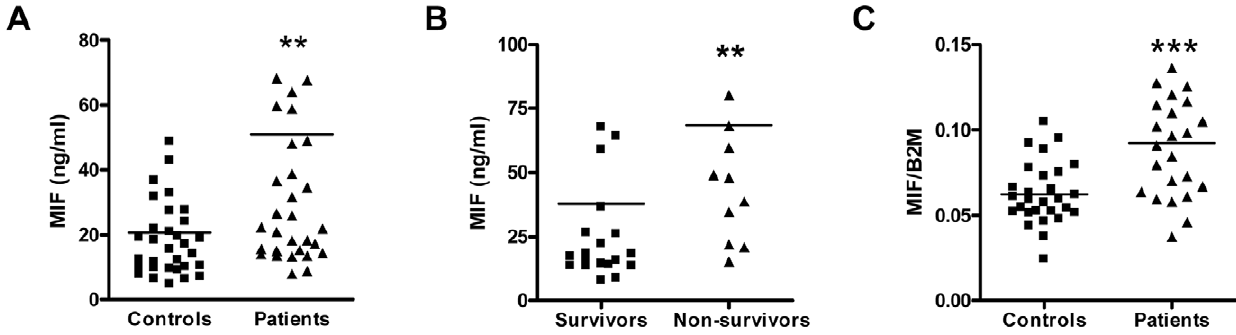
Figure 1. MIF plasma and leukocyte mRNA levels are elevated in melioidosis patients and correlate with poor outcome. In patients ( m , n=34) with melioidosis, strongly increased plasma concentrations of plasma MIF were present on admission when compared to healthy controls ( & , n=32) ( A ). Patients who went on to die from melioidosis had higher MIF plasma concentrations on admission than patients who survived ( B ). MIF mRNA was strongly upregulated in the peripheral blood leukocytes of melioidosis patients compared to healthy controls ( C ). B2M: b 2 microglobulin. ** p , 0.01; *** p , 0.001.